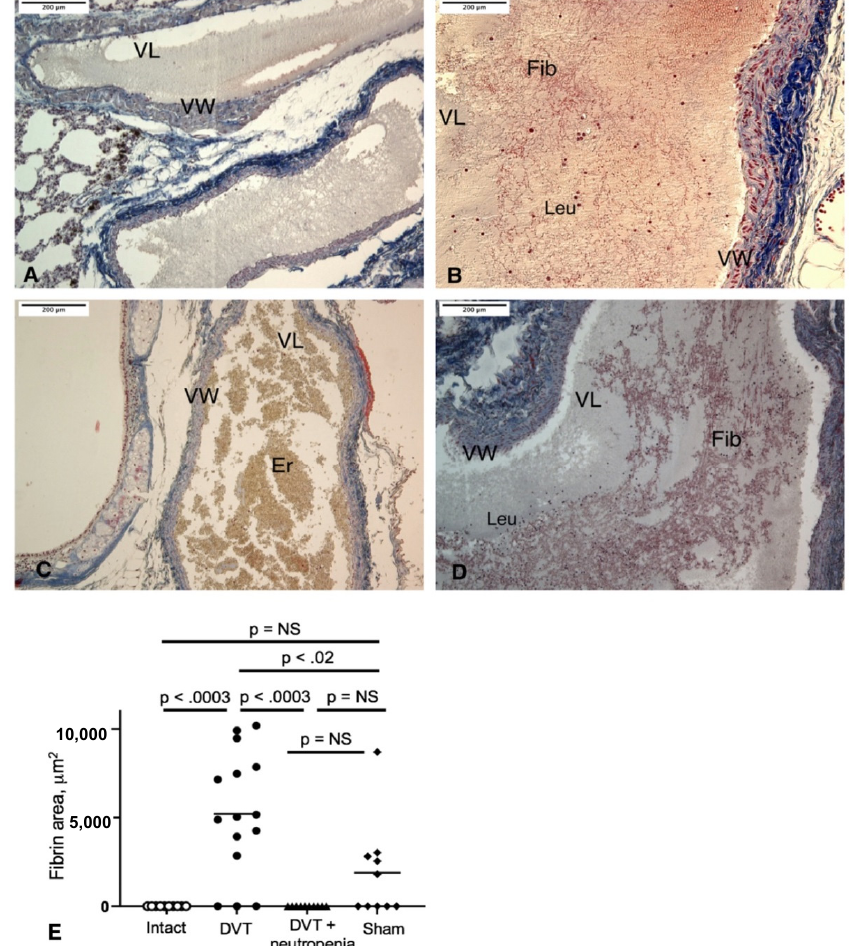
Figure 3. Microscopic changes in the branches of the PA ( A – D ) and area of fibrin in PA branches ( E ): ( A ), PA branch in an intact rat without thrombus inside. ( B ), PA branches of a non-neutropenic rat after 48 h IVC ligation, with firmly packed young fibrin meshwork adjacent to the vessel wall and occluding most of the vessel lumen. ( C ), PA branch of a neutropenic rat after 48 h IVC ligation, free of fibrin deposition, with yellow erythrocytes inside the vessel. ( D ), Separate loose young fibrin fibers in the PA branch of a sham-operated rat. ( E ), Area of fibrin in PA branches was measured by ImageJ in random fields of view (one per section). Statistical comparison was performed by Kruskal – Wallis test. NS, non-significant. N = 10 (intact), 15 (48 h IVC stenosis/DVT), 10 (48 h IVC stenosis/DVT + neutropenia), 10 (sham). VW, vessel wall; VL, vessel lumen; Leu, leukocytes; Fib—fibrin, Er—erythrocytes. Scale bar 200 μ m. Representative images out of 10–15 experiments.